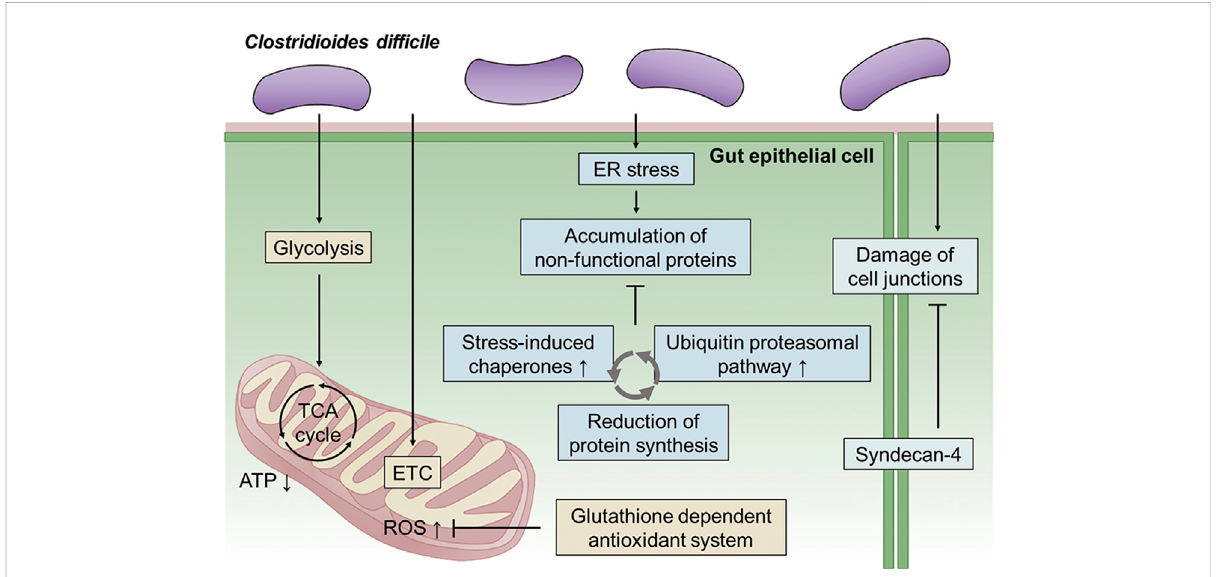
FIGURE 10 Schematic overview of metabolic regulation in Caco-2 cells cultured with C. dif fi cile . First, C. dif fi cile causes inhibition of energy metabolism, including glycolysis and the TCA cycle, along with downregulation of the electron transport chain in Caco-2 cells during the early stage of infection. Mitochondrial dysfunction leads to ROS production, and in response, Caco-2 cells upregulate the glutathione-dependent antioxidant system. Second,ERstressinCaco-2cellscausedbyCDIcausestheaccumulation ofnonfunctionalproteins(unfoldedandmisfoldedproteins). Caco-2 cellsdegradenonfunctionalproteinsthroughtheubiquitinproteasomalpathwayandreduceproteinsynthesis.Finally, C.dif fi cile inducesdamageto cell junctions, including tight junctions and adherens junctions, in Caco-2 cells. In response, Caco-2 cells upregulate syndecan-4 to maintain intestinal epithelial barrier function. ETC, electron transfer chain; ER, endoplasmic